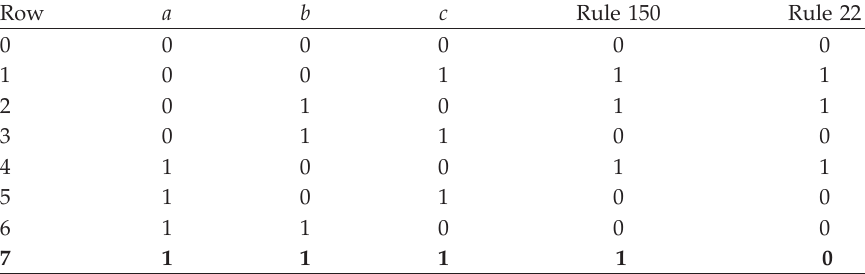
Table 7: Comparison of Truth Tables of Rules 150 and